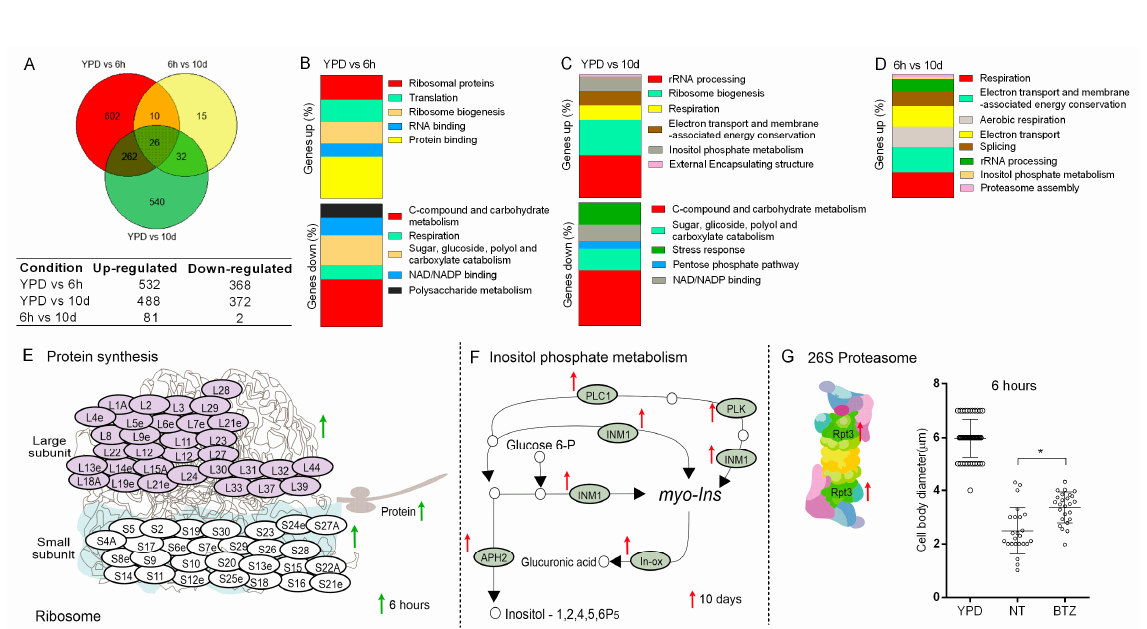
DEGs are shown in Table S1.